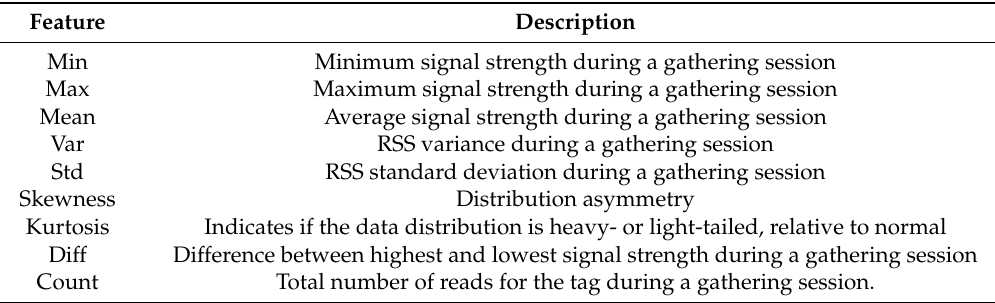
Table 1. Attributes extracted from RSS.